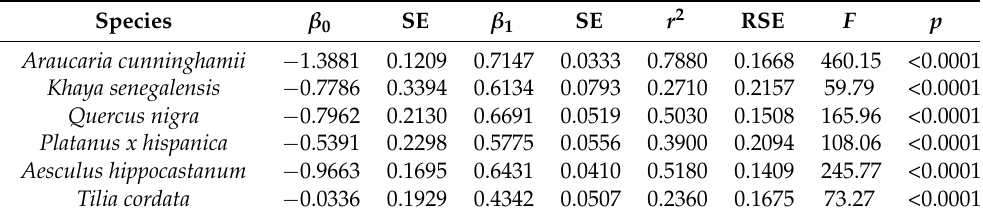
Table 5. Linear regression models for stem diameter ( d ) to crown radius ( cr ) Equation (13) for all six species (ordered according to